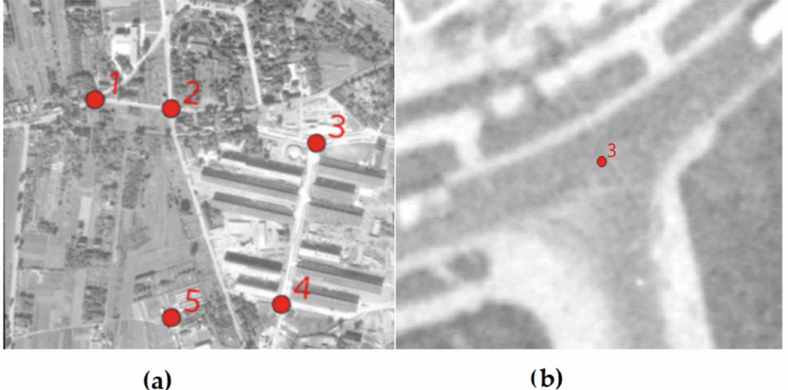
Figure 5. Location of GCPs in the study area—( a ), identification problem of GCP—( b